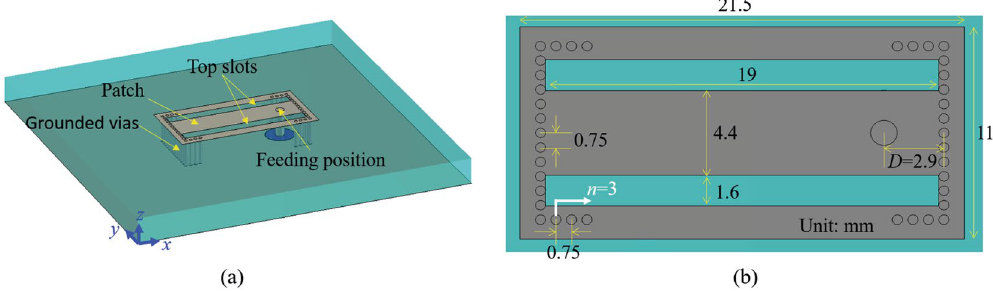
Figure 2. Geometry of the dual-mode bidirectional antenna. ( a ) Perspective view and ( b ) partial enlarged detail of the antenna. The diameter of the grounded vias is 0.5 mm. The color gray represents copper material and the color aquamarine represents dielectric